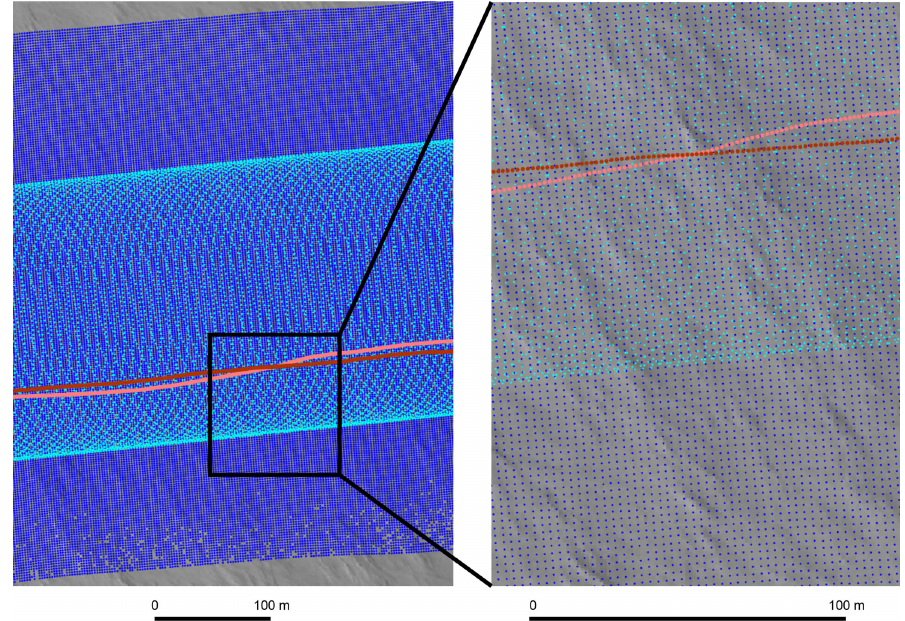
Figure 3. Sample footprint spacing for the UAF lidar (dark blue) and ATM (cyan), and the 88S Traverse ground-based GPS data are in shades of red (GPS A is in light red while GPS B is in dark red). WorldView-2 imagery, copyright 2017, DigitalGlobe,